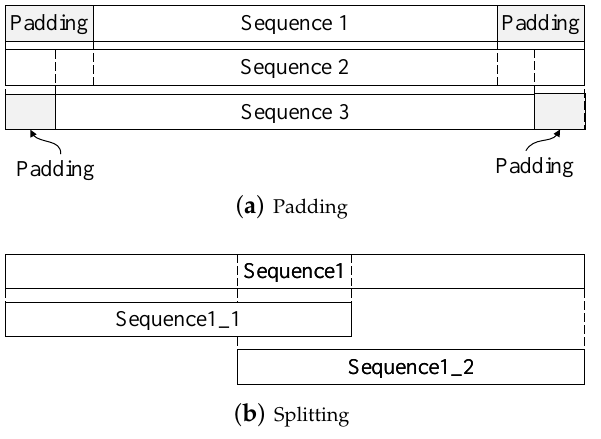
Figure 5. Diagram of the unified length of the time series